Question: In one sentence, what is this figure communicating?
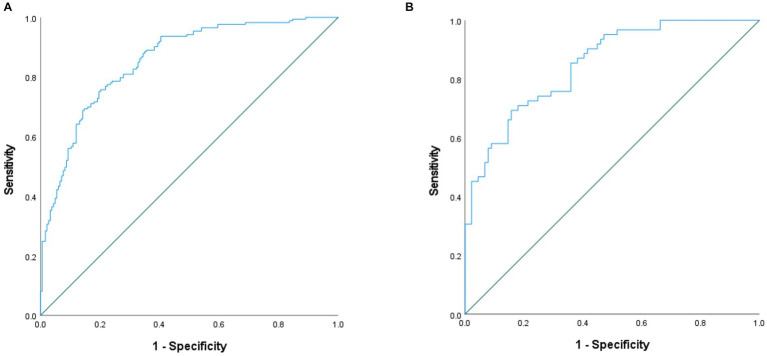
Answer: (A) ROC curve of the training set. (B) ROC curve of the validation set.